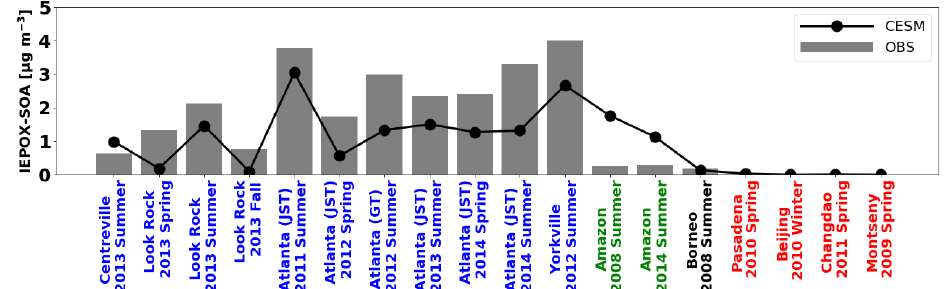
Figure 3. Global surface IEPOX SOA observations (gray bar) versus the model results (solid line). Detailed information about site locations, time period, and IEPOX SOA concentrations is available in Table S2. The southeastern US, the Amazon, and urban regions are shown in blue, green, and red, respectively. Table 1. Description of IEPOX SOA simulations under present and future